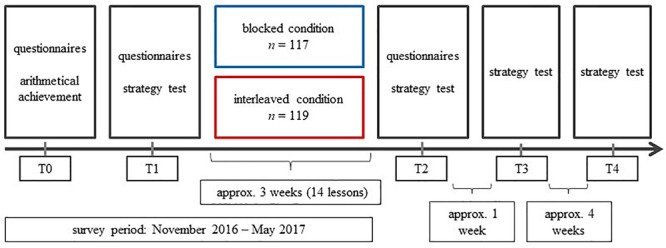
Design of the study.